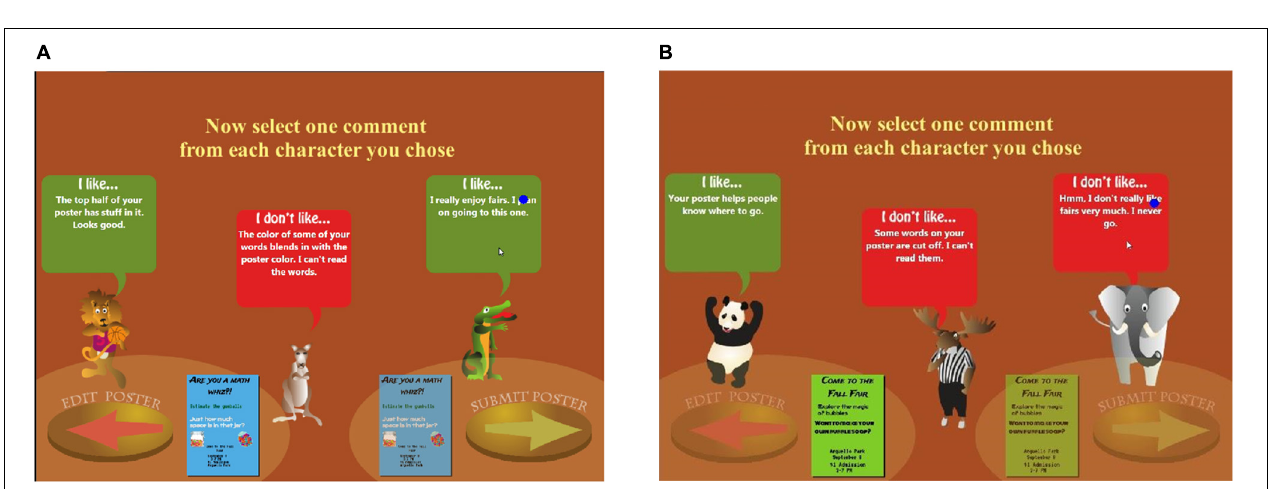
FIGURE 1 | The two Posterlet game versions: the original (Choose) version of the Posterlet game (A) and the modified (Assign) version of the Posterlet game (B) . The latter game version was employed in the present study.